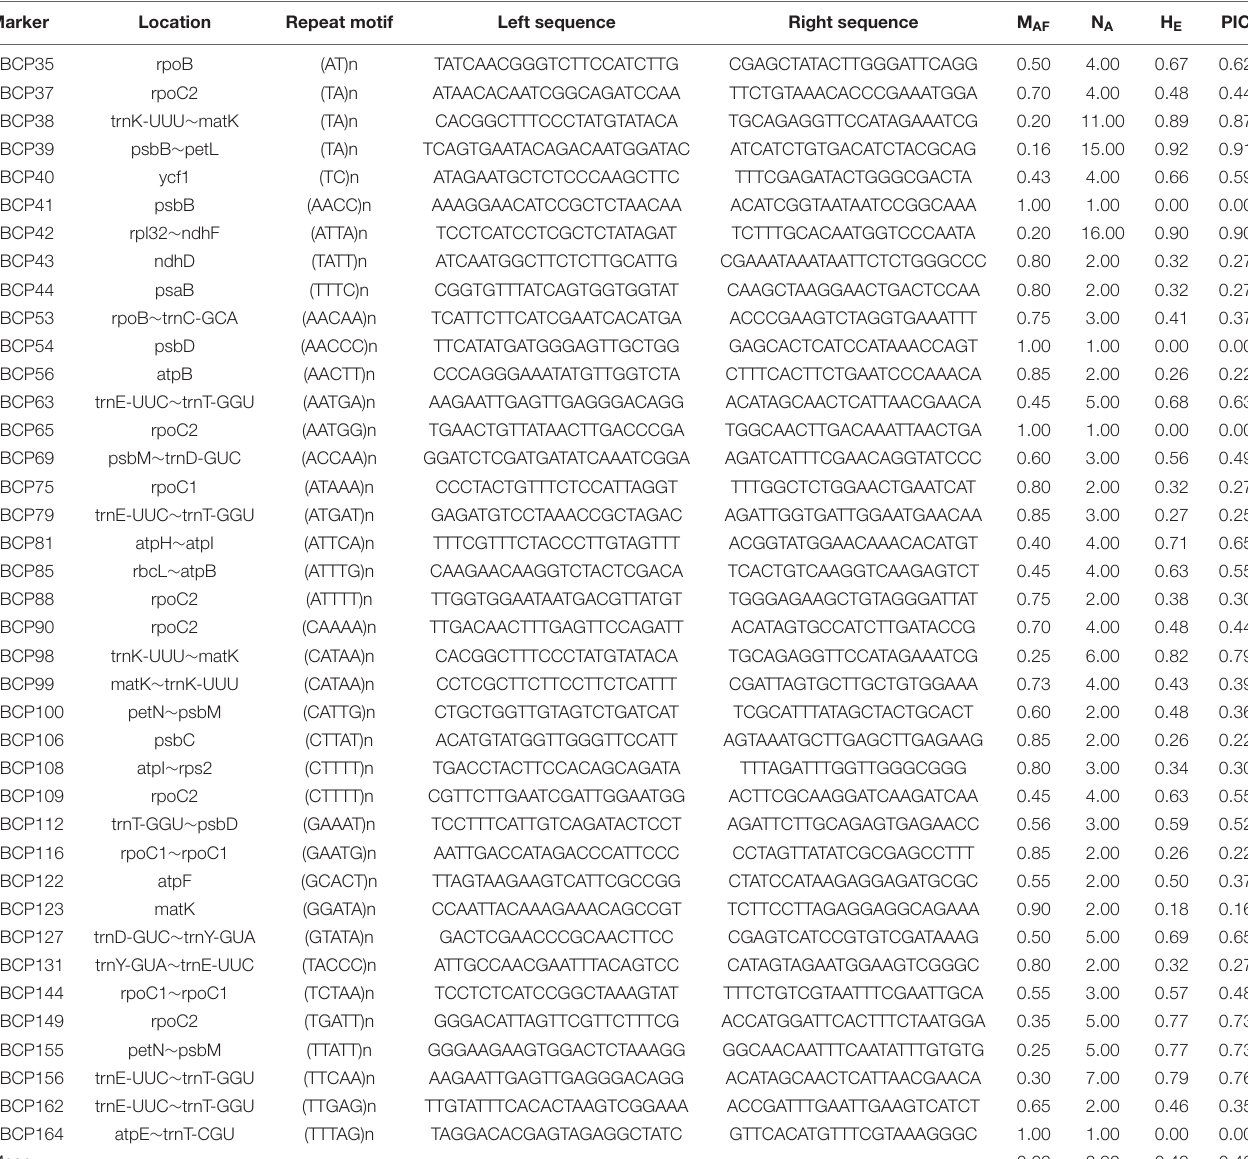
TABLE 2 | Summary of the 39 polymorphic chloroplast simple sequence repeat markers and their genetic diversity statistics across 20 Vicia spp. accessions. Marker Location Repeat